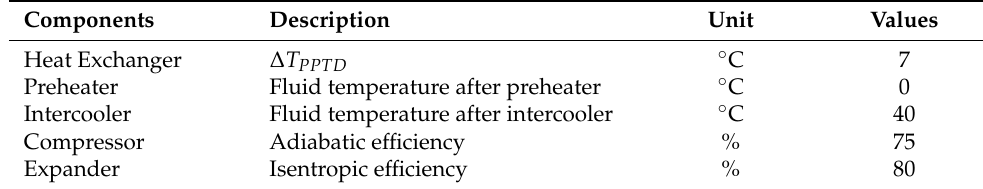
Table 2. Main component simulation conditions for the BOG re-liquefaction systems [4,25].